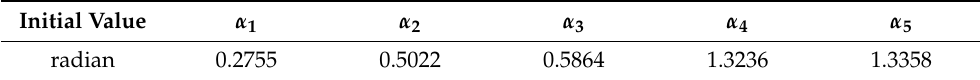
Table 4. Actual parameter of sin + 3rd harmonic magnetic pole position.